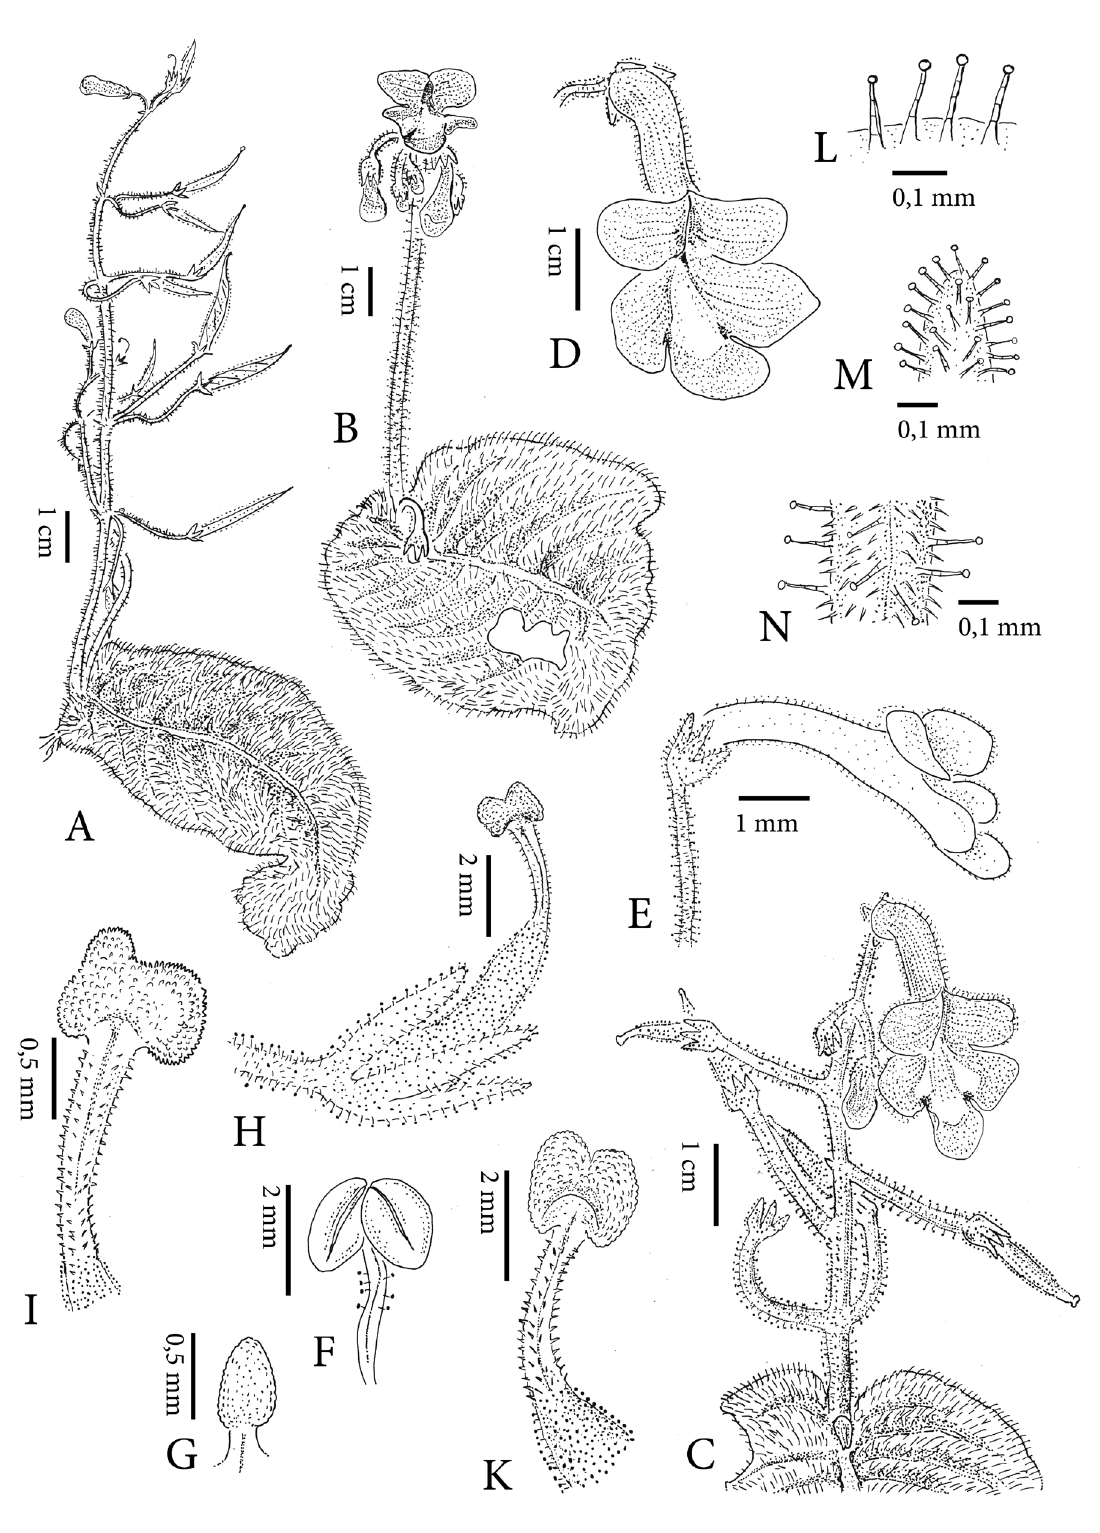
Figure 1 – Streptocarpus malachiticola. A–B . Habit. C . Inflorescence. D . Flower, frontal view. E . Flower, lateral view. F . Stamen. G . Staminode. H . Calyx with ovary, style, and stigma. I . Style and stigma. K . Tip of ovary, style, and stigma. L . Glandular hairs on calyx. M . Tip of sepal with glandular hairs. N . Hairs on pedicel. A, C–K from Malaisse 11427 ; B from Schaijes 3850 . Illustration by Eberhard